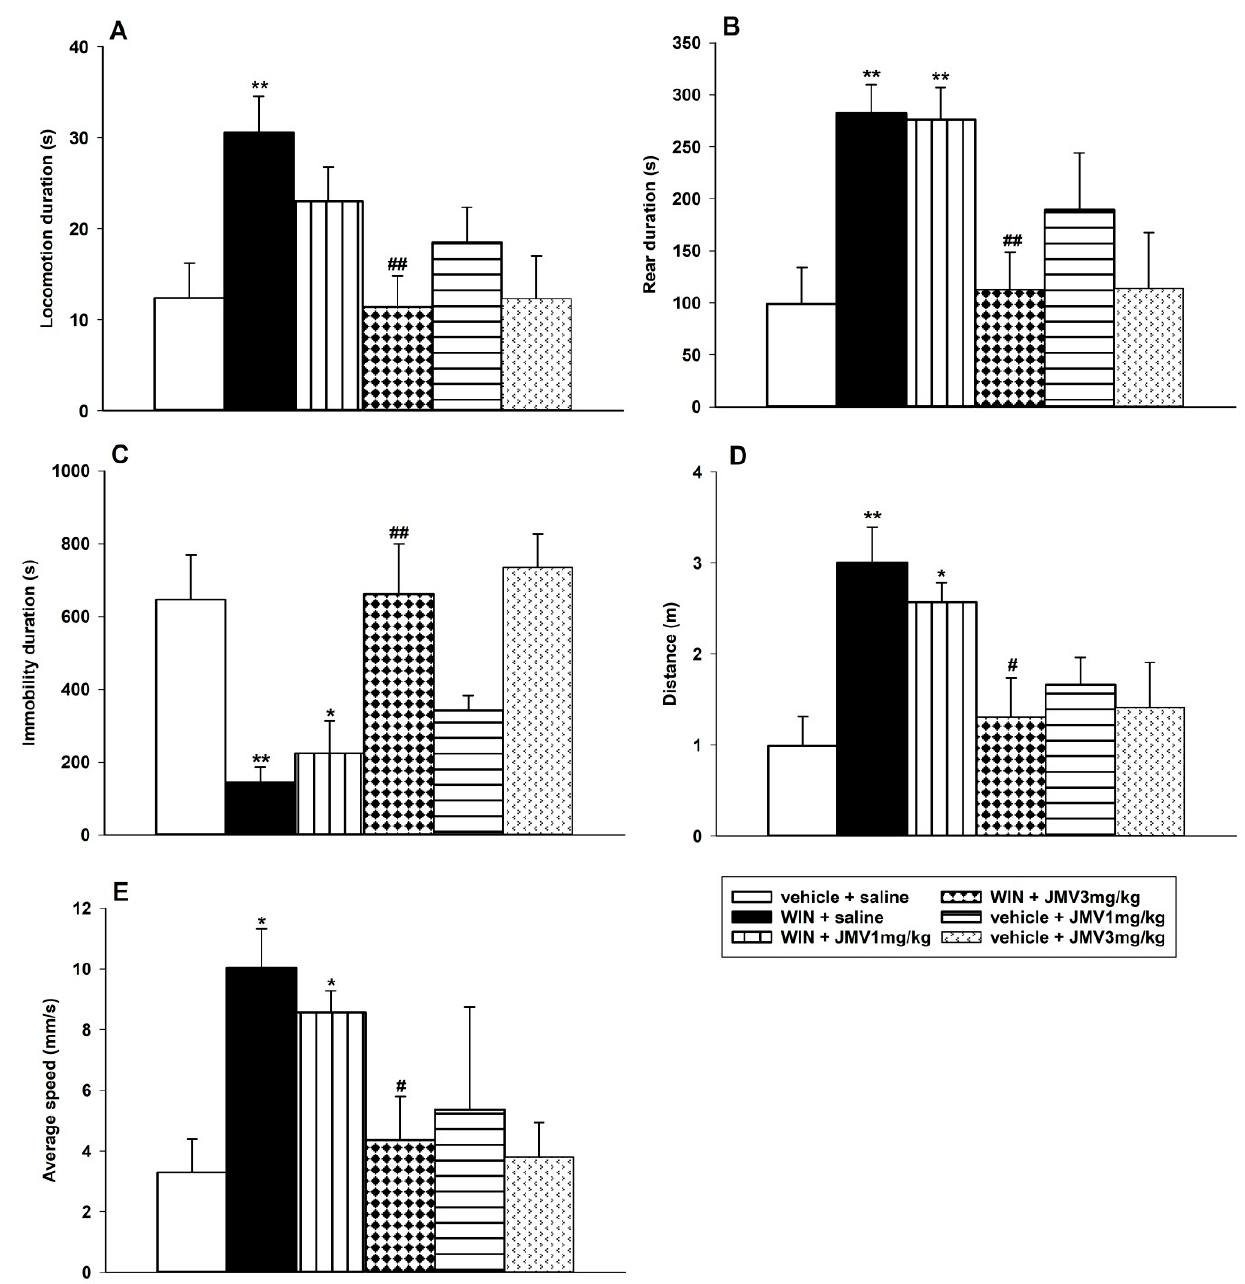
Figure 1. Effects of JMV2959 on the WIN55,212-2-induced behavioural changes in rats, in the fully automated behaviour monitoring LABORAS cage. JMV2959 (0, 1 and 3 mg/kg i.p.) was injected immediately before placing the rat into the cage, and after 20 min of habituation a stimulatory WIN55,212-2 dose 0.1 mg/kg or vehicle was administered intraperitoneally.